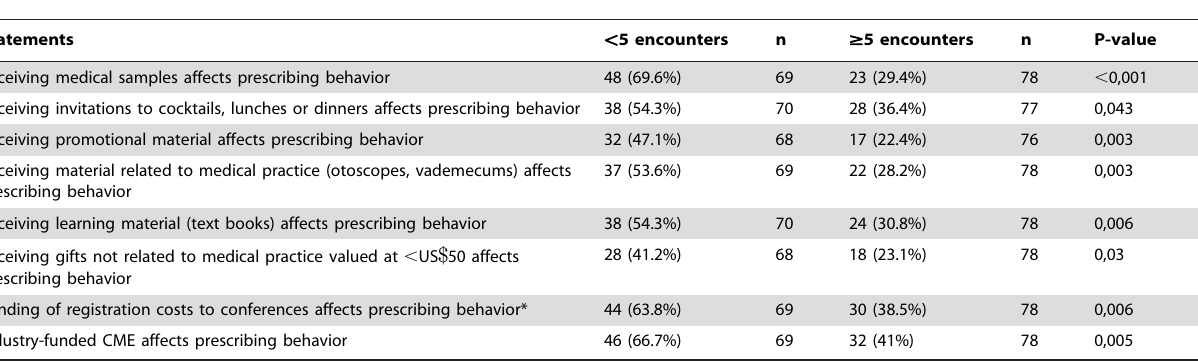
Table 6. Attitudes of physicians (attendings and residents) towards industry stratified by number of encounters held with pharmaceutical